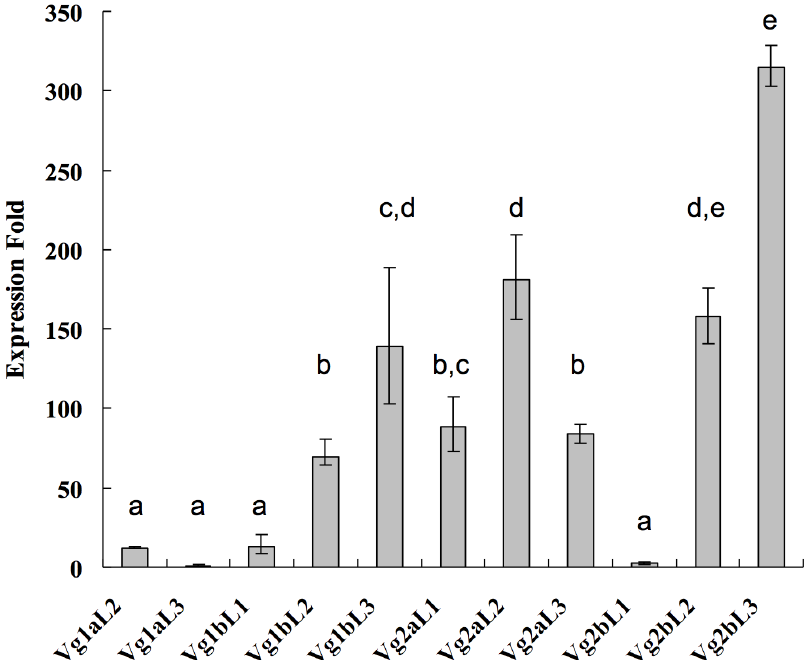
Figure 3. Variation in reporter gene (GFP) expression among transgenic Drosophilamelanogaster lines. Relative expression levels of GFP were normalized to the expression of ribosomal protein 49 ( rp49 ). Expression folds are calculated by comparison to line Vg1aL3, which had the lowest detectable GFP expression. Error bars represent standard errors. Letters represent statistical differences.